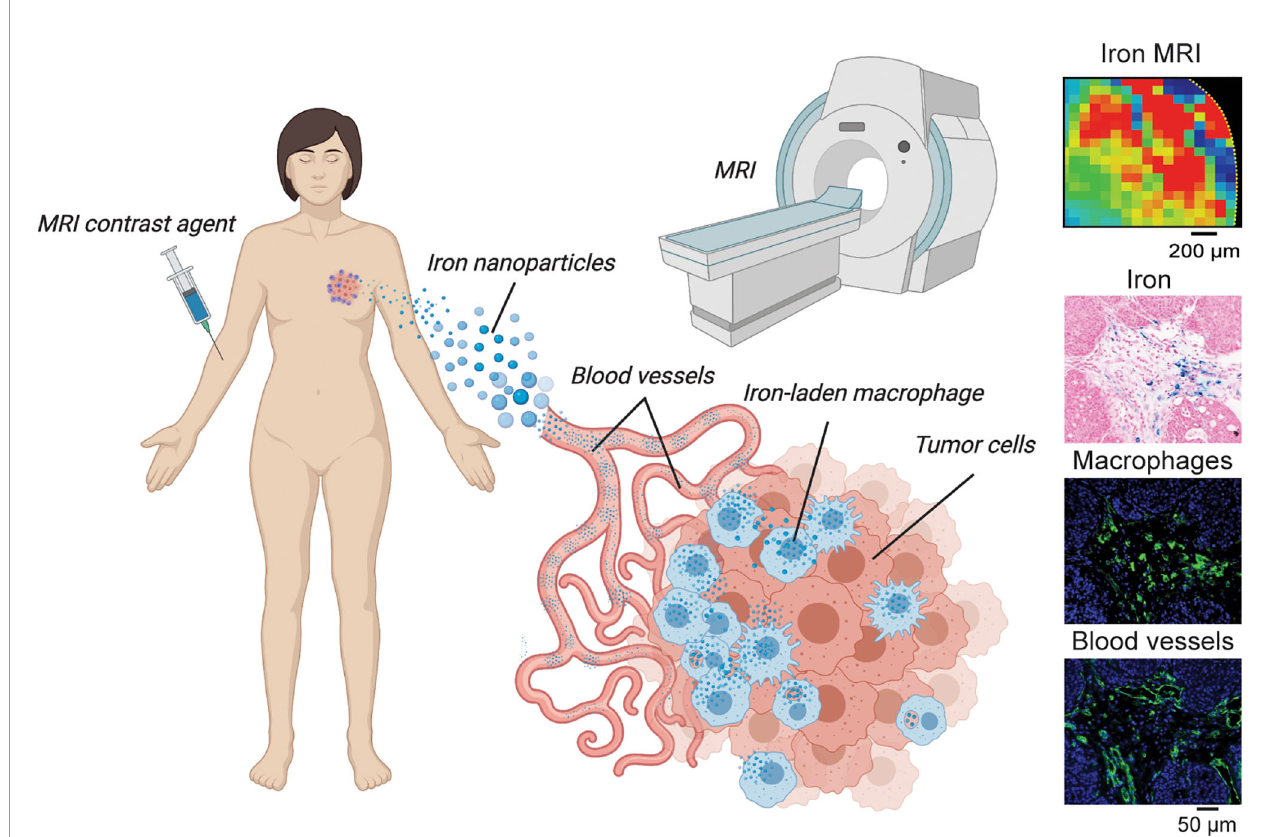
FIGURE 4 | TAM iron imaging in cancer. In many studies focusing on iron-laden population of macrophages magnetic resonance imaging (MRI) is used to localize and monitor these cells during tumor growth and immunometabolic therapy response. Here, iron nanoparticle contrast agents are injected intravenously and subsequently are delivered to the tumor where TAM phagocytosis occurs. Quantitative iron MRI provides in vivo quantitative detection of iron containing macrophages in animal models and patients. Cytological imaging con fi rms associations between iron deposits within macrophage accumulation and vascular in fi